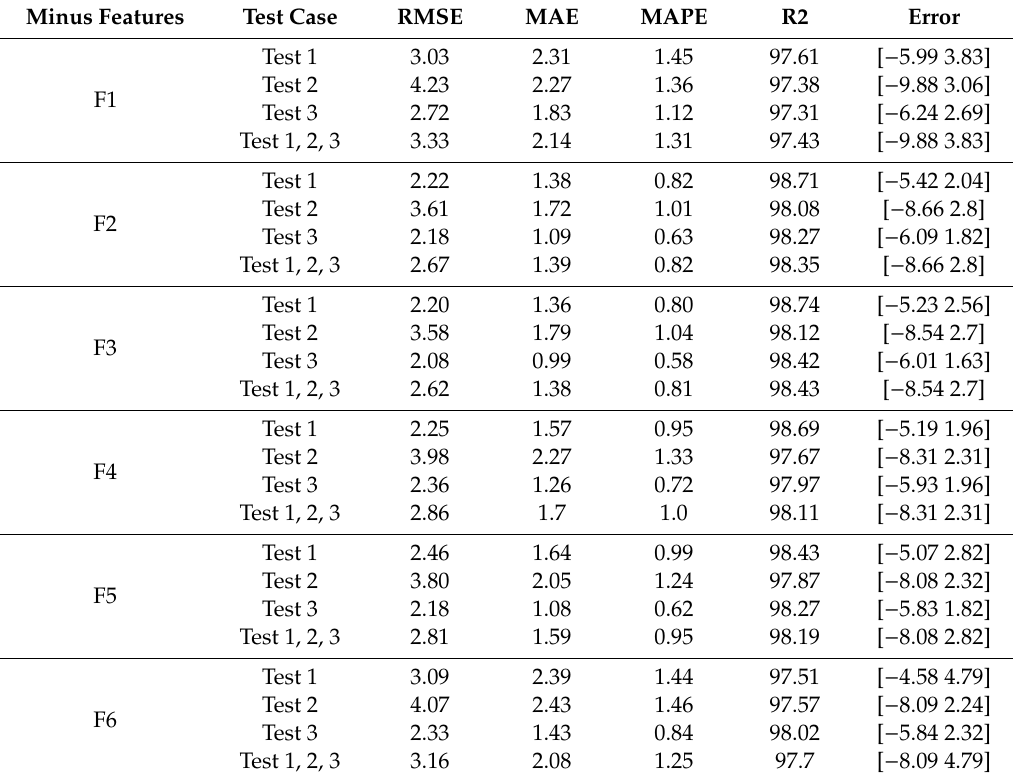
Table 7. Statistical results of the SOH estimation.